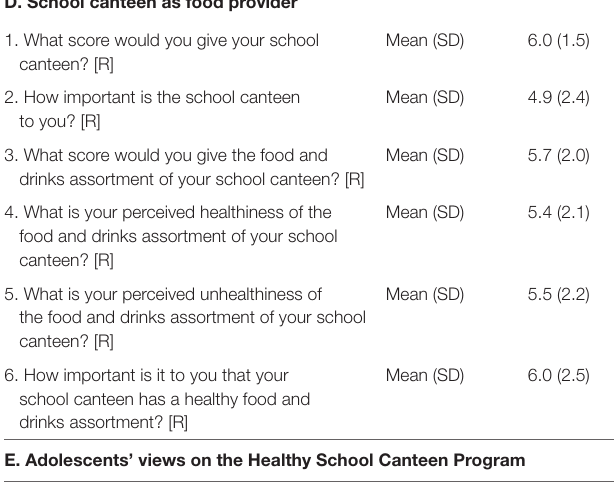
TaBle 3 | Dutch adolescents’ ( N = 133) survey responses on school canteen